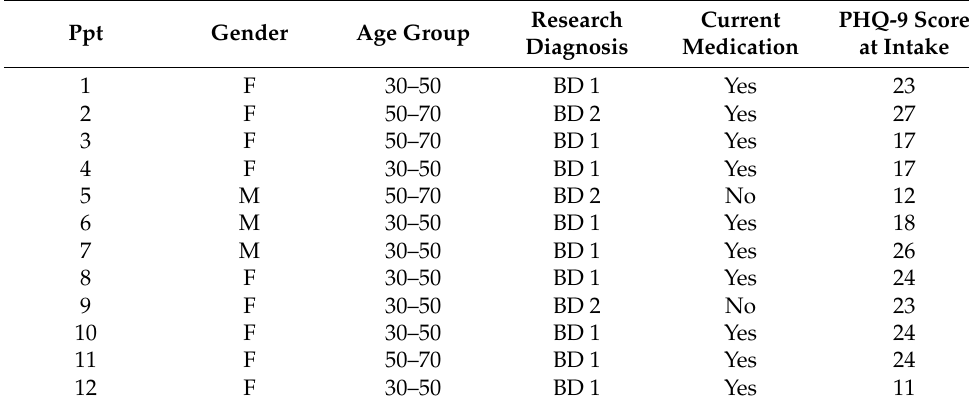
Table 2. Clinical and demographic characteristics of